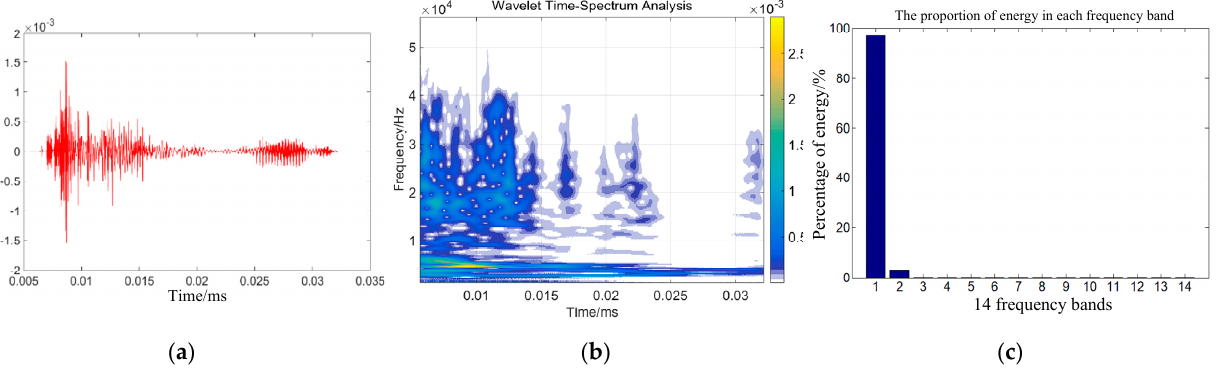
Figure 3. Time-frequency analysis of target sound emission signals under 960 J. ( a ) Acoustic emi-sion time domain waveform. ( b ) Sound emission wavelet time spectrum. ( c ) Acoustic transmitted signals for each frequency band.